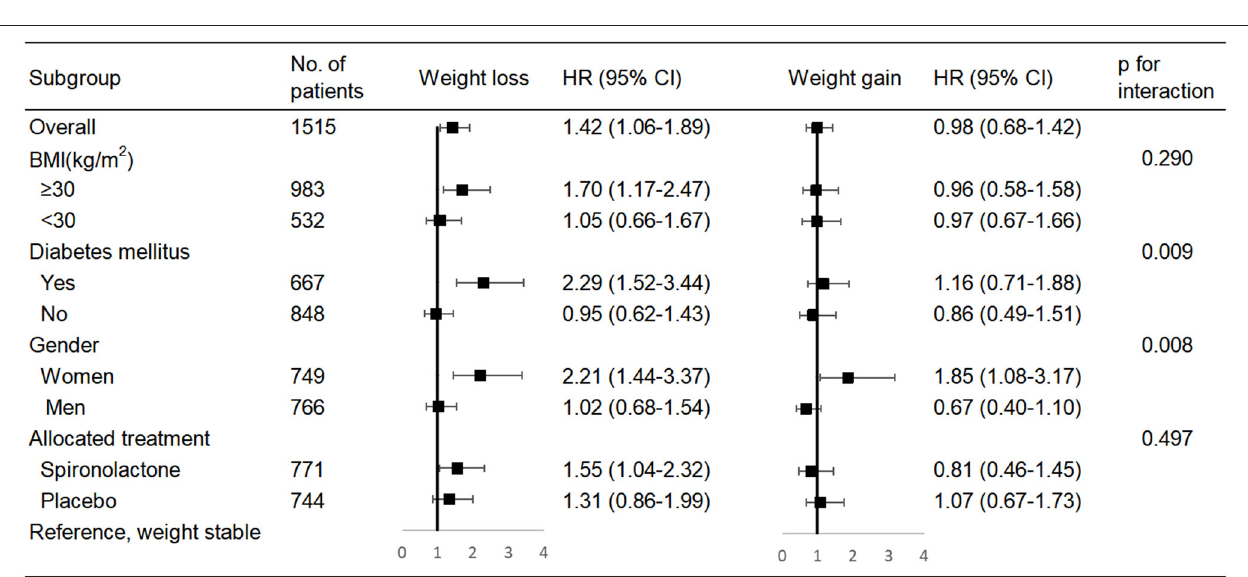
FIGURE 2 | Multivariable Cox regression analysis for various subgroups. BMI, body mass